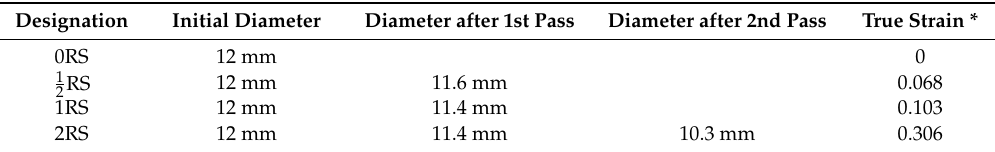
Table 2. Rotary swaging parameters.